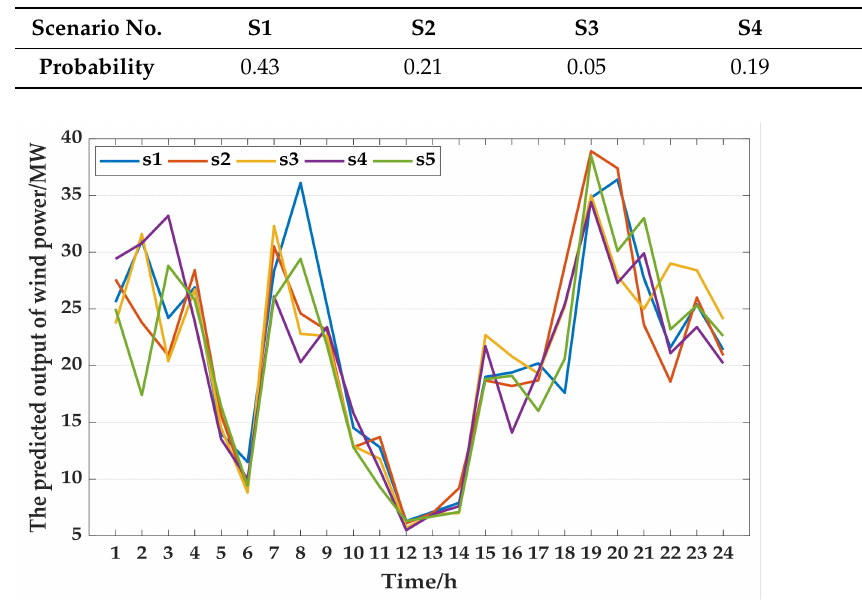
Figure 7. Predicted output of wind power under each